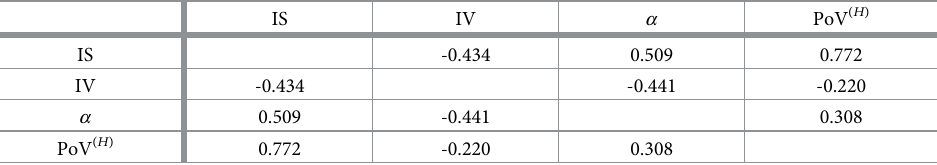
Table 3. Pearson’s correlation coefficients between pairs of statistical measures for participants without